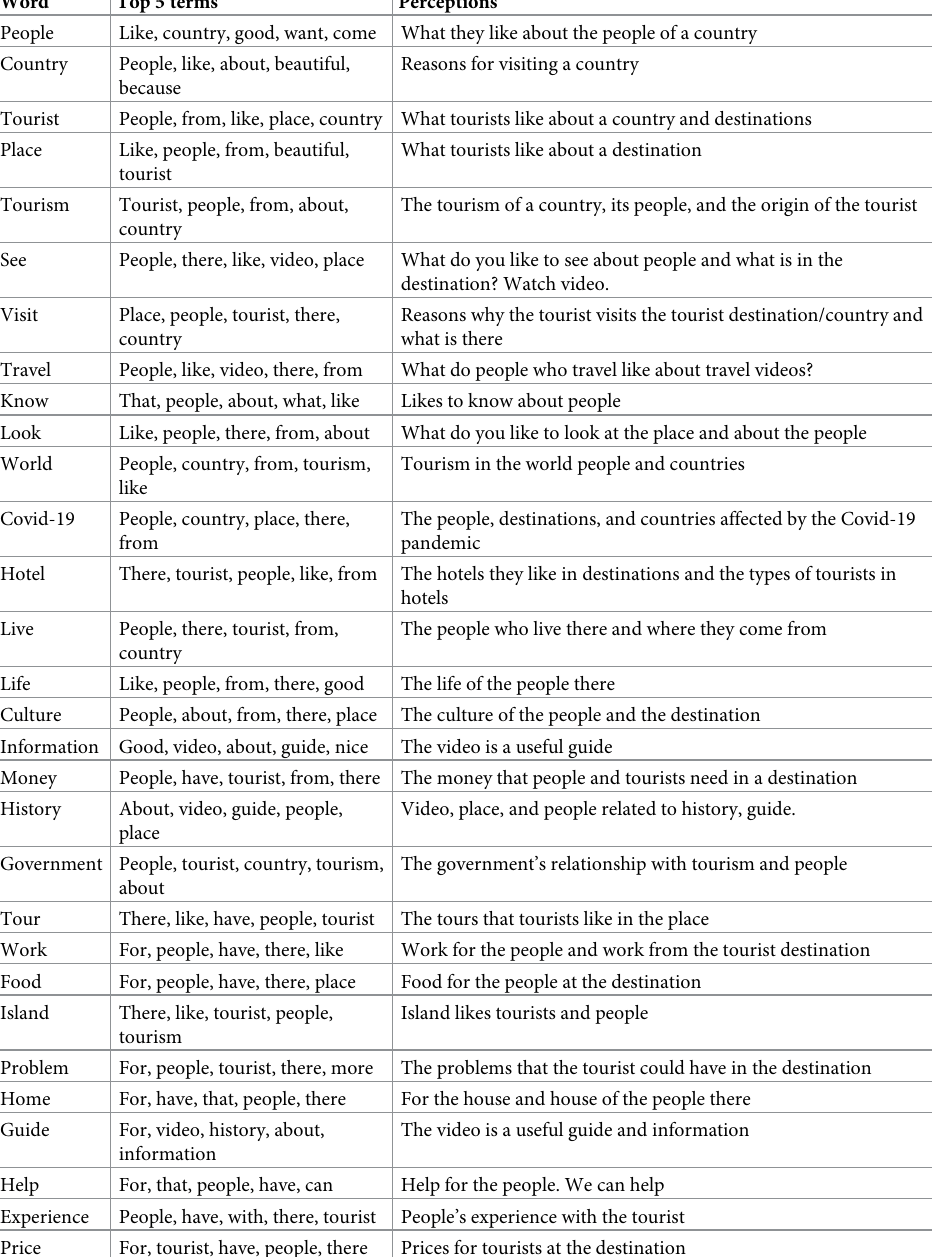
Table 2. The five words associated with each discussion topic and the perceptions in the comments to tourism vid- eos for each discussion topic. Word Top 5